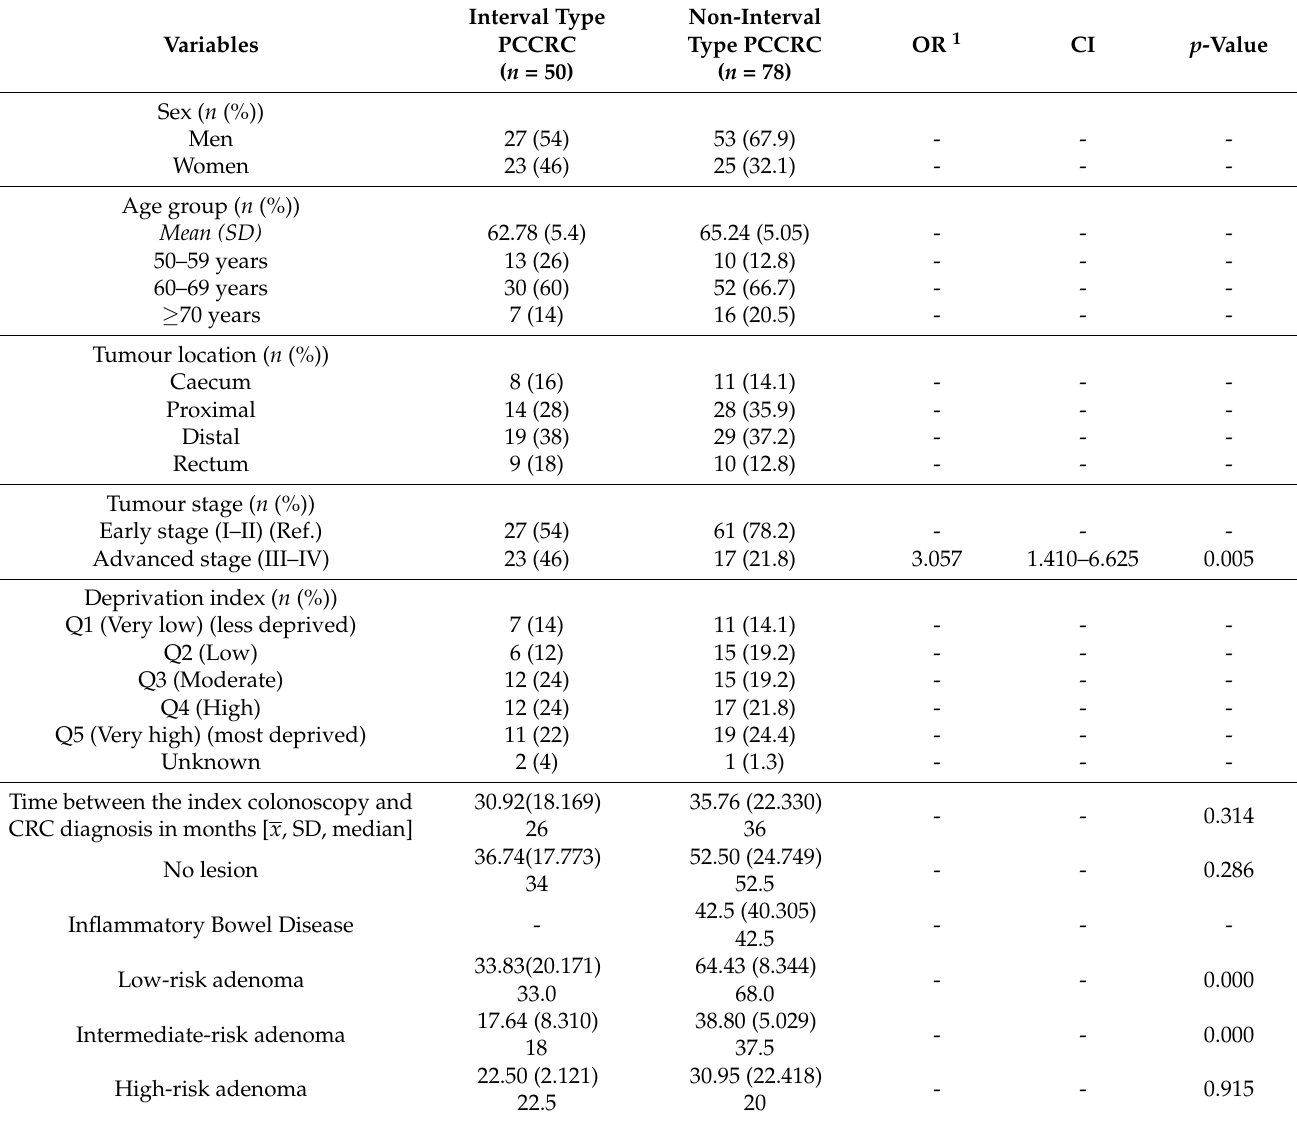
Table 2. Characteristics of PCCRC interval type and PCCRC non-interval